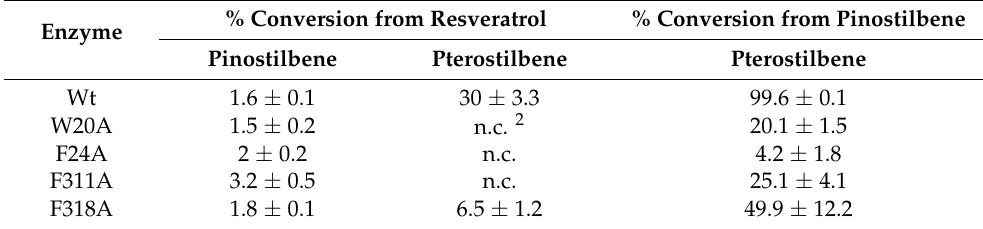
Table 1. Enzymatic activity of VvROMT alanine variants 1